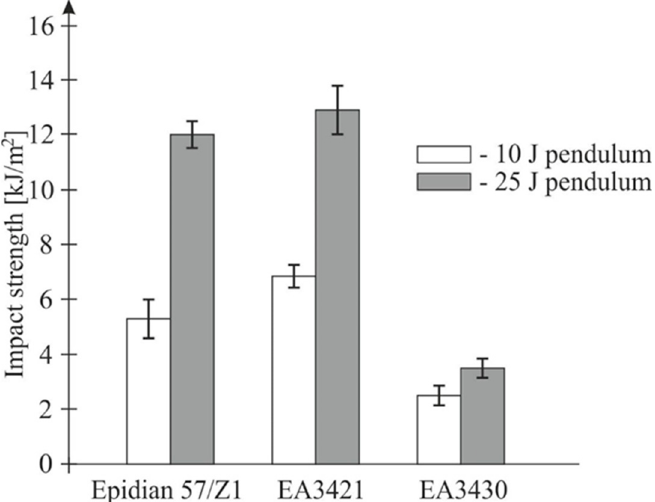
Figure 4. The impact strength of the three adhesives for the test energy Ek = 10 J, by means of pendulums "10 J" (V = 3.81 m/s) and the "25 J" (V = 2.42 m/s) .